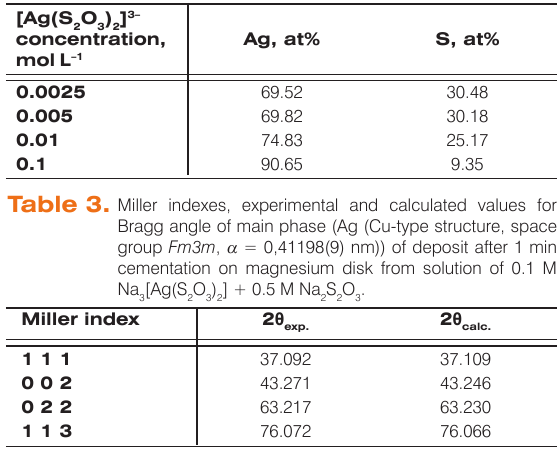
O ) ] 3– solutions at 20 o C 2 3 2